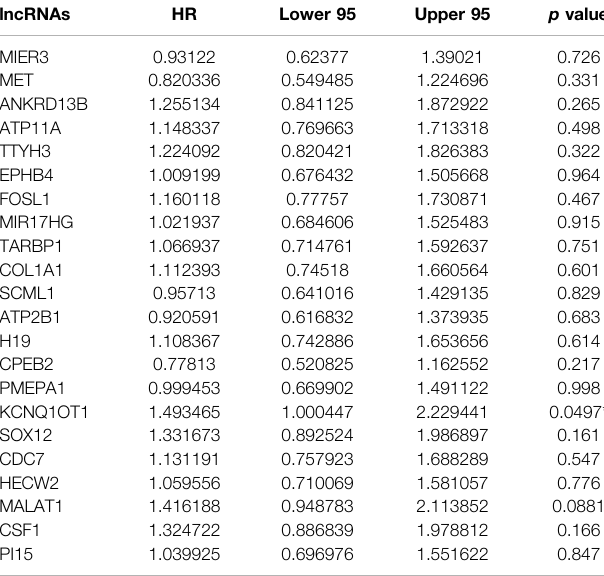
TABLE 1 | Survival analysis with the critical hub genes.